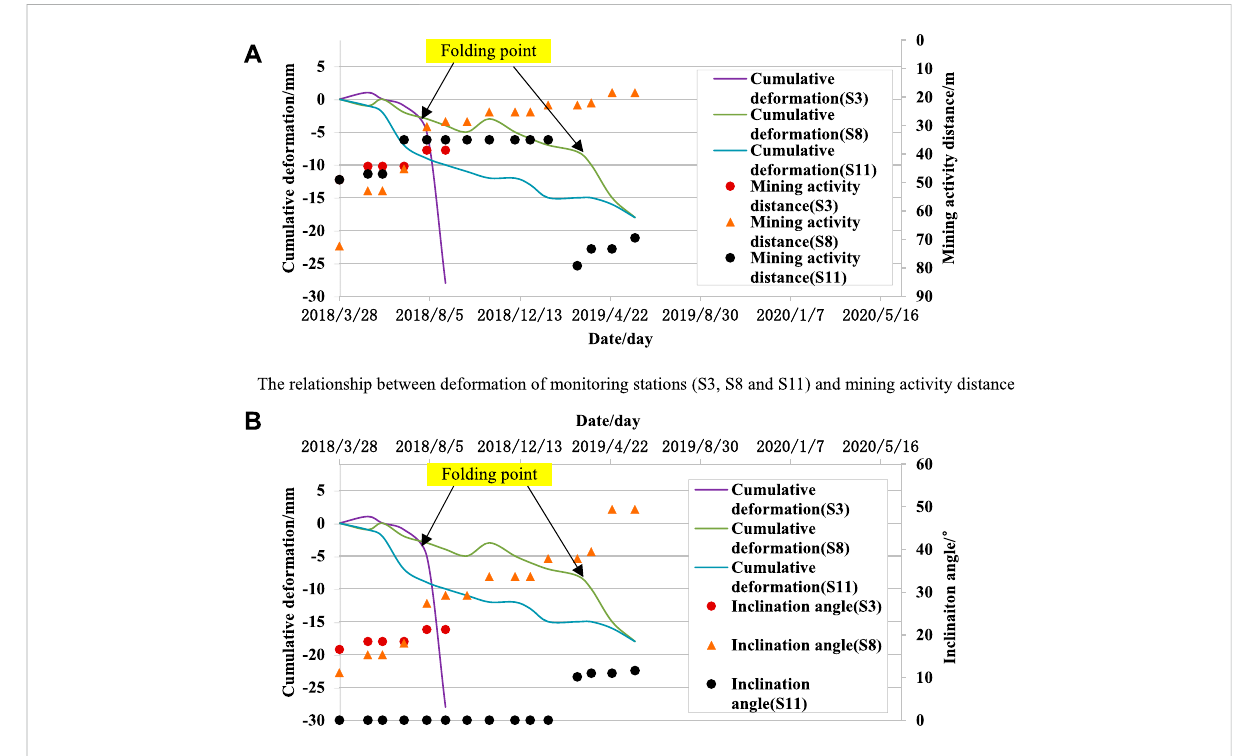
FIGURE 9 Relationship between deformation of monitoring stations (S3, S8, and S11) and mining under polar coordination system. (A) The relationship between deformation of monitoring stations (S3, S8, and S11) and mining activity distance. (B) The relationship between deformation of monitoring stations (S3, S8, and S11) and inclination